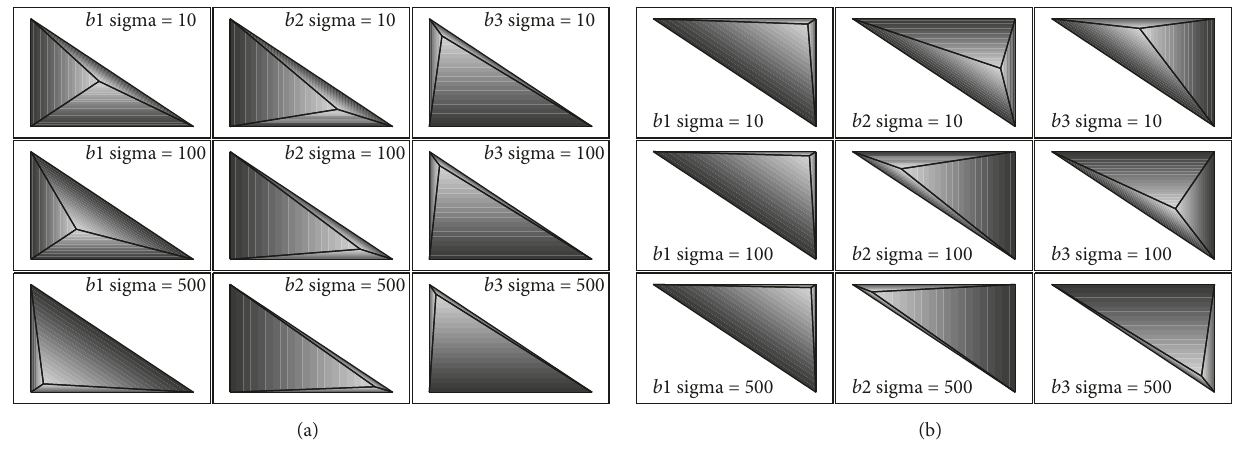
Figure 5: Bubble functions, 𝑏 1 , 𝑏 2 , 𝑏 3 , in a typical element having (a) two inflow edges and (b) one inflow edge, when 𝜖 = 10 −3 , 𝛽 = ( sin 72 ∘ , cos 72 ∘ ) , 𝜎 = 10, 100, 500 , and 𝑁 = 10 (figure reproduced from [15] [under the Creative Commons Attribution License/public